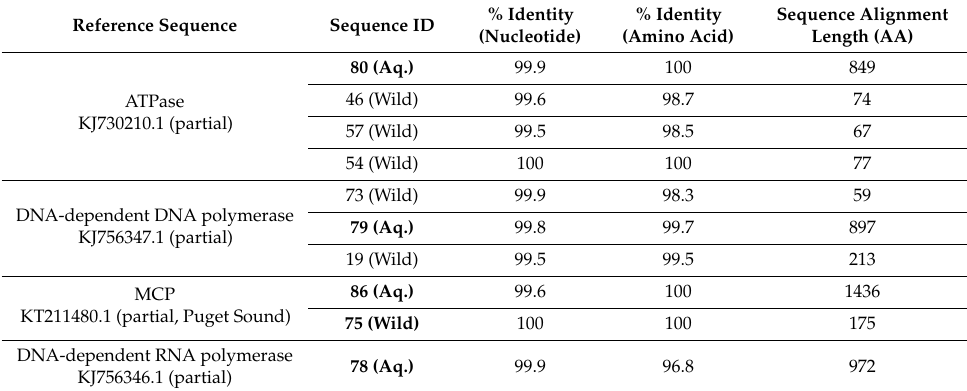
Table 1. Basic Local Alignment Search Tool (BLAST) summary of erythrocytic necrosis virus (ENV) sequences from Chinook salmon compared with available herring derived ENV sequences on GenBank. The origin of each sequence is indicated as aquaculture (Aq.) or wild Chinook salmon. Sequences used in phylogenies are in bold.